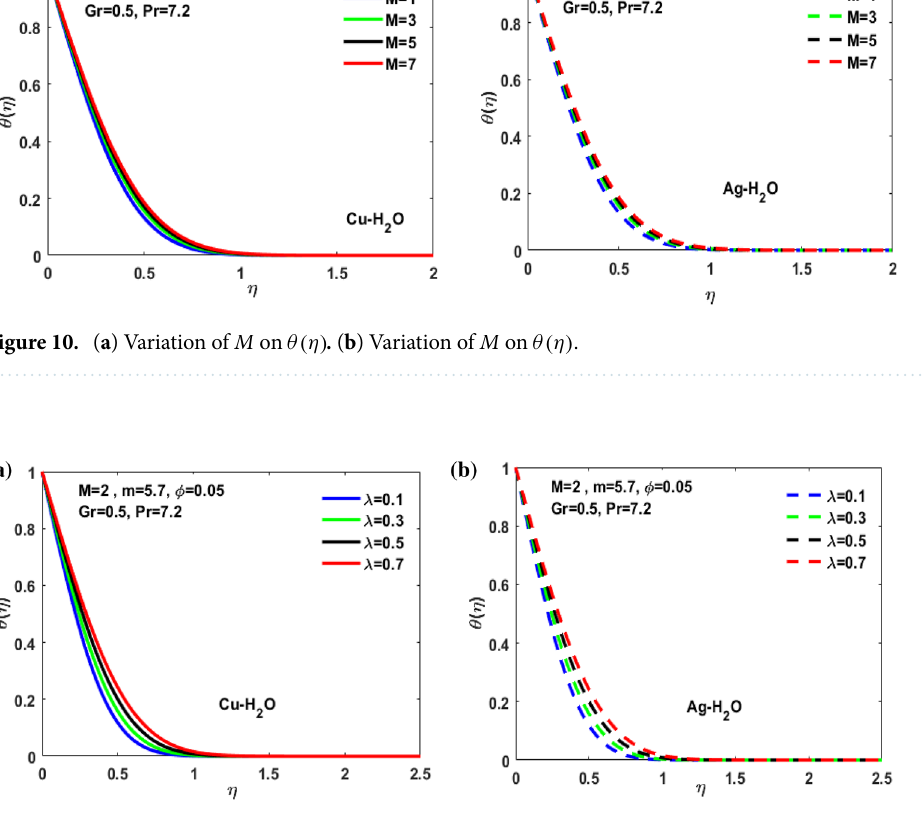
Figure 11. ( a ) Inspiration of (cid:31) on θ(η) . ( b ) Inspiration of (cid:31) on θ(η)